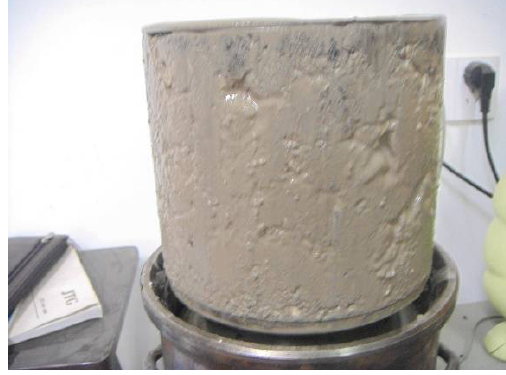
Figure 11. Specimen appearance under gyration compaction.